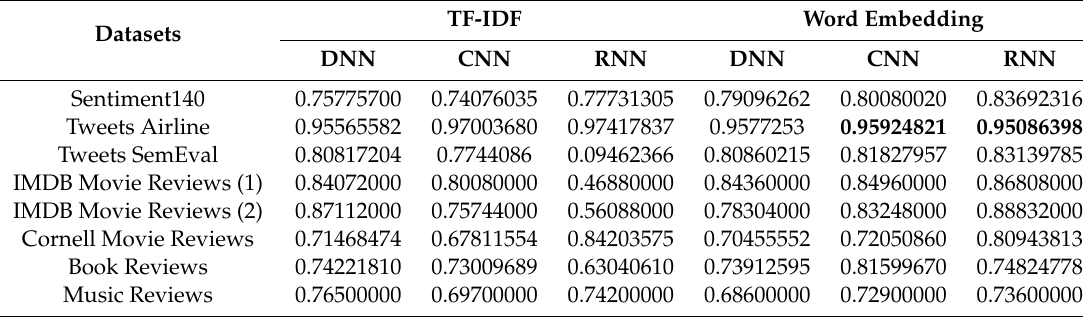
Table 3. The recall comparison for di ff erent datasets.